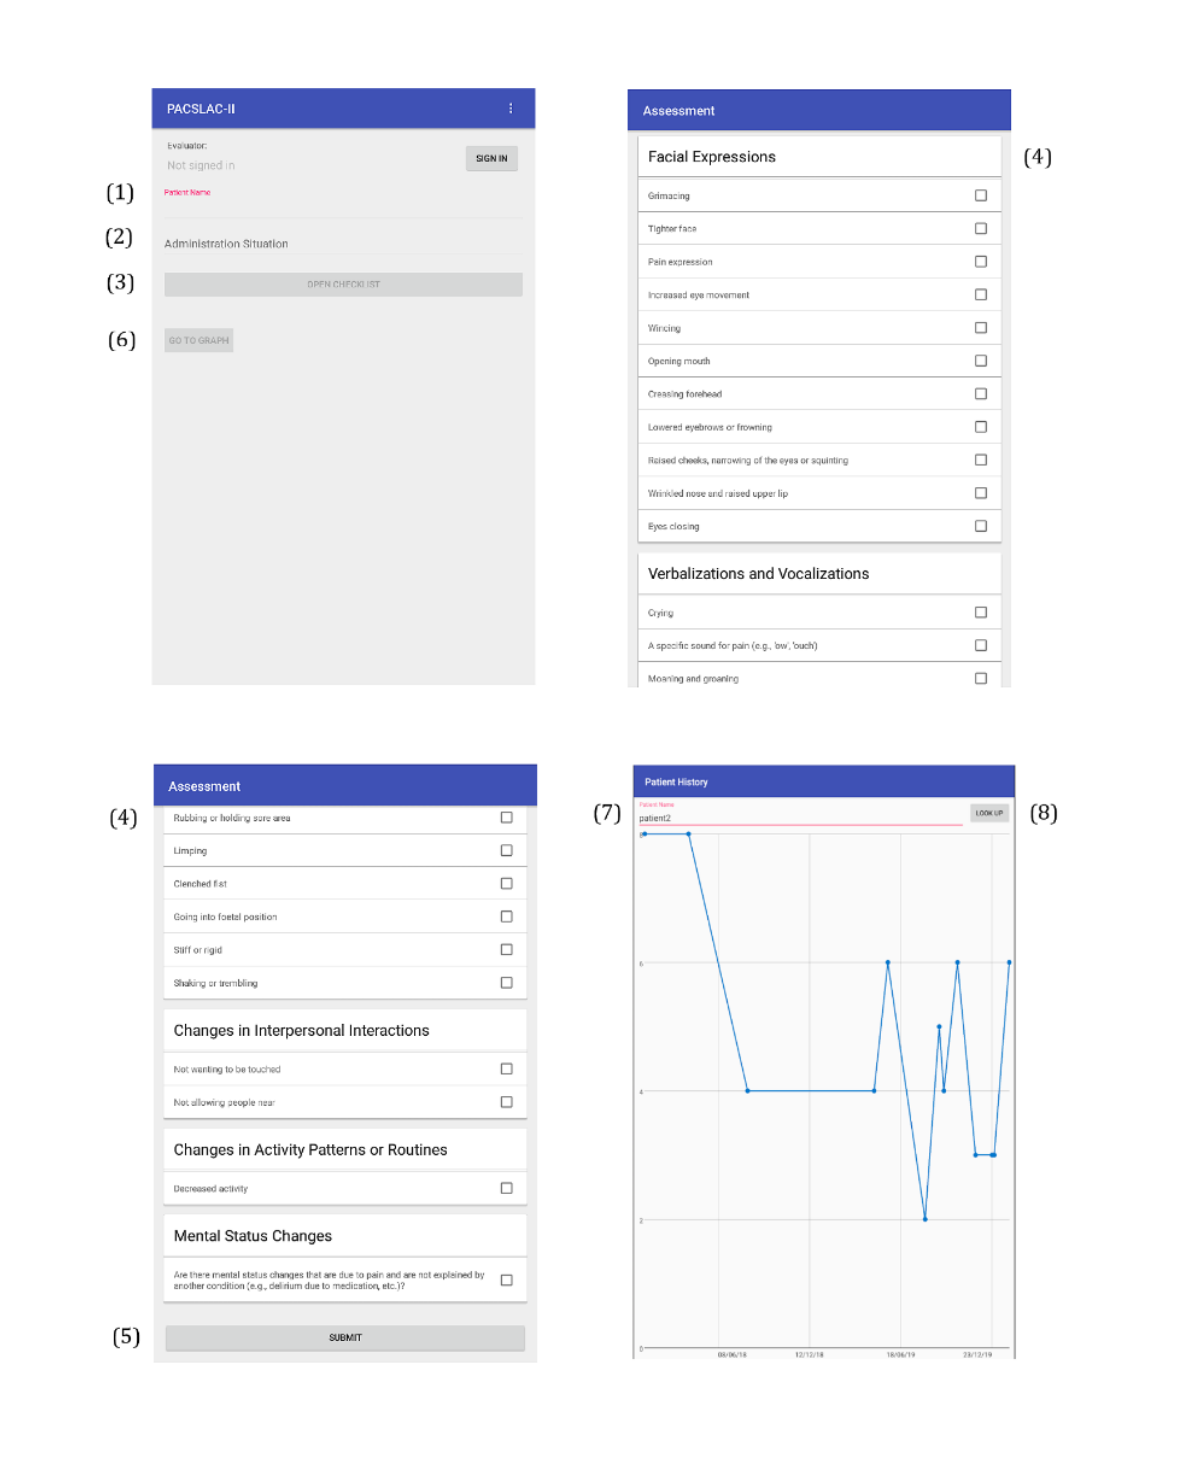
Figure 1. Screenshots of the Pain Assessment Checklist for Seniors With Limited Ability to Communicate (PACSLAC)-II tablet app with numbers corresponding with the instructions provided to participants. The screenshot on the bottom right of the figure shows the graph for a sample participant with the date of the PACSLAC-II administration on the horizontal axis and the PACSLAC-II score on the vertical